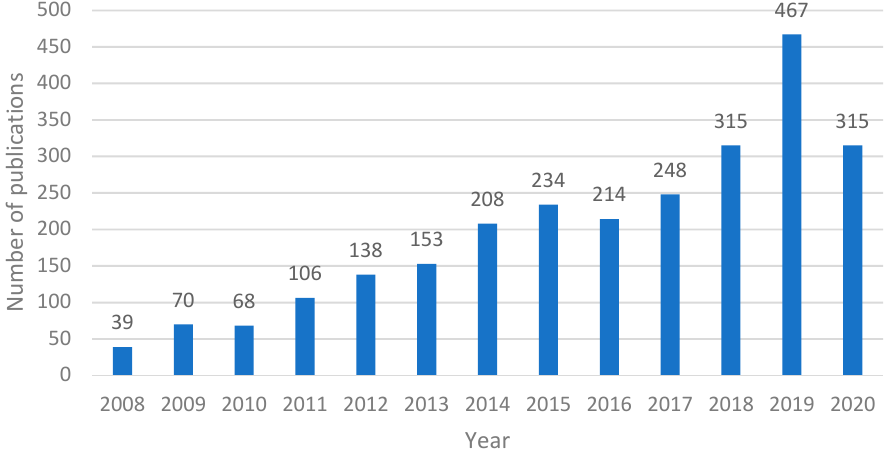
Figure 3. Number of finger-vein-related publications of Google Scholar per year for the last 13 years.